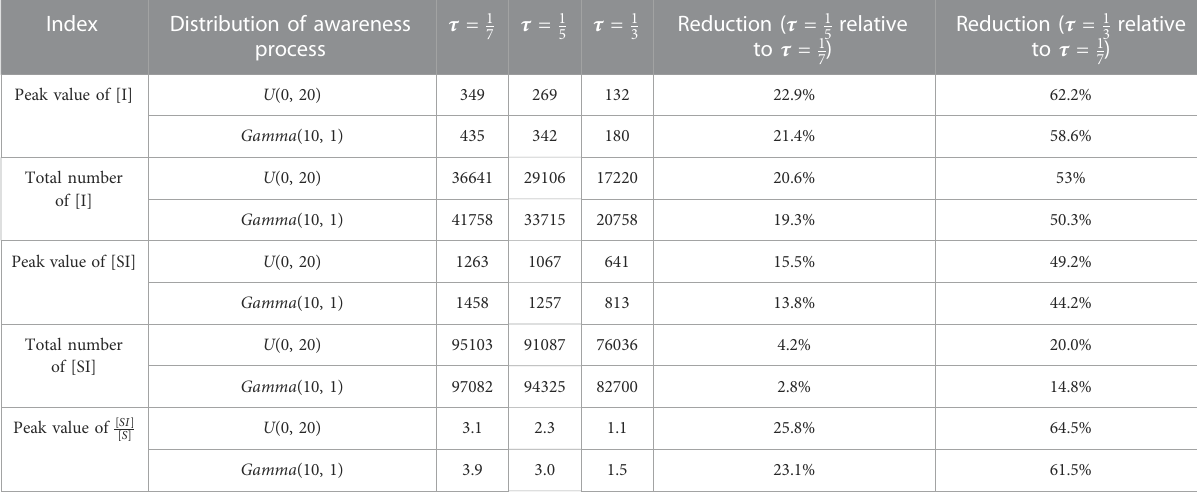
TABLE 1 Impacts of contact tracing and awareness of